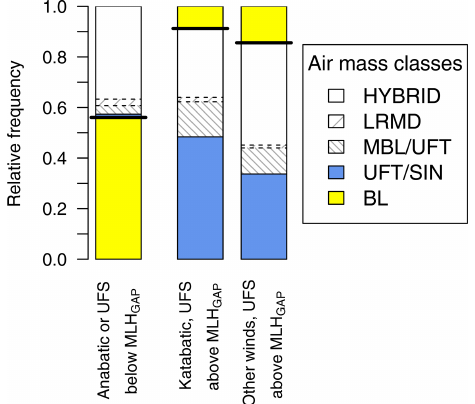
Figure 9. Comparison between the statistical and mechanistic clas- sifications of air masses. The mechanistic classes were based on the boundary layer height at GAP (MLH GAP ) and thermally induced anabatic and katabatic winds (Sect. 2.5) and accounted for 3%, 5%, and 17% of the statistically classified cases (from left to right). The thick black lines show the percentages considered as an agreement between the approaches. MLH GAP was discarded if clouds were detected below 4 km a . s . l . . LRMD and MBL/UFT are subclasses of